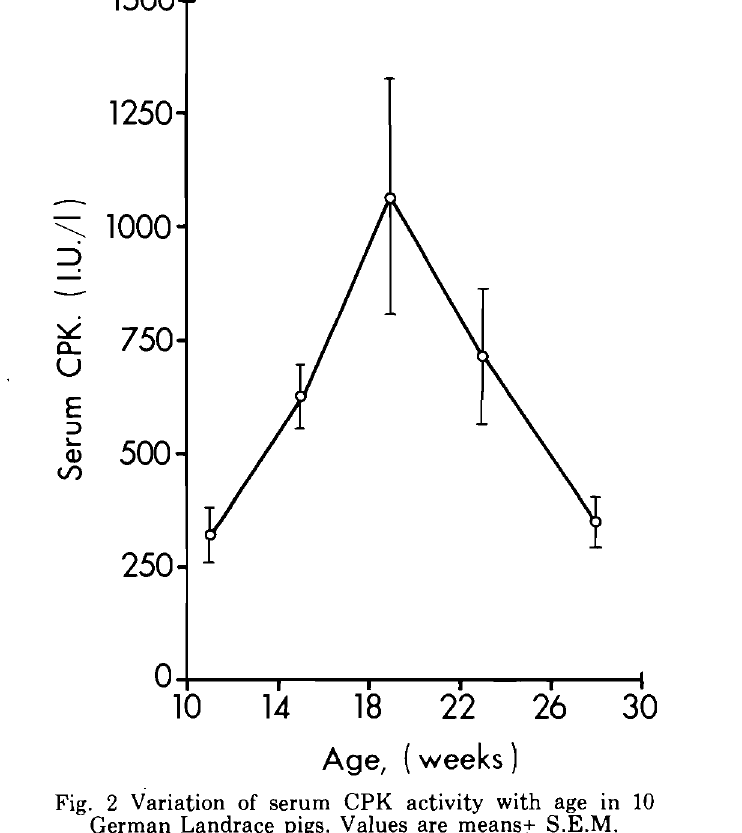
Fig. 2 Variation of serum CPK activity with age in 10 German Landrace pigs. Values are means± S.E.M.